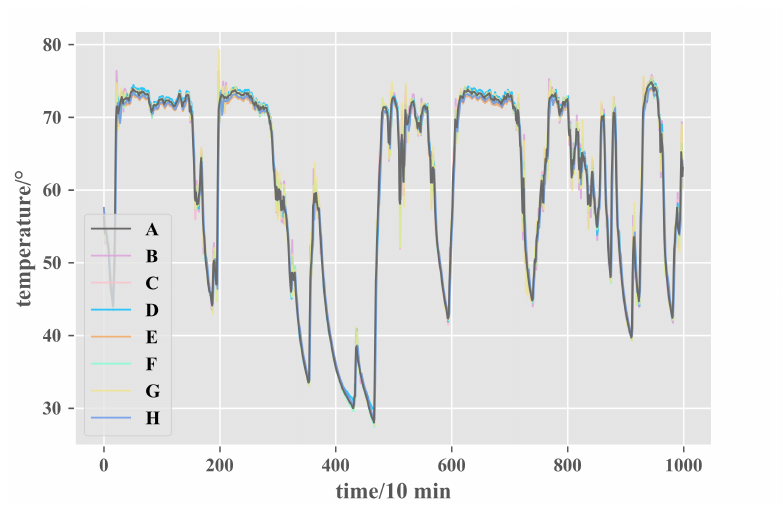
Figure 13. The comparison of different models for gearbox output shaft temperature prediction in #2.